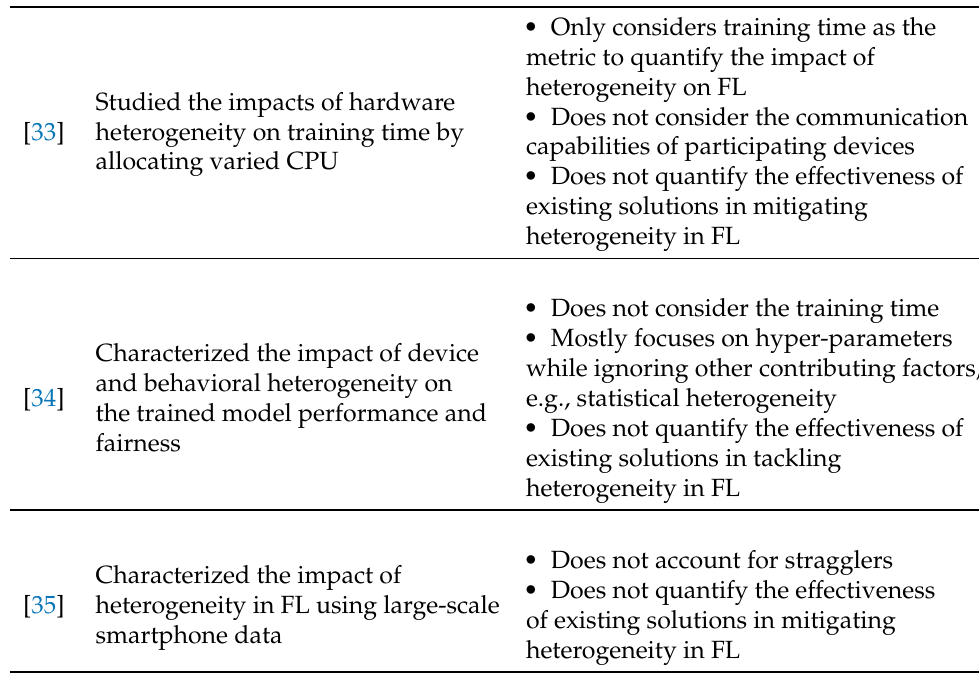
Table 1. Previous works along with their key contributions and drawbacks.